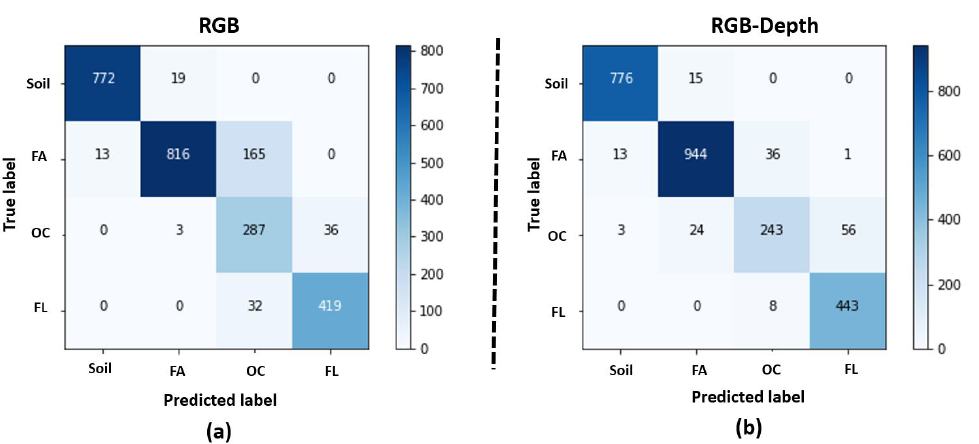
Figure 6. Confusion matrices for the best method found in Table 2, i.e., CNN. ( a ) for the RGB images and ( b ) for the RGB-Depth